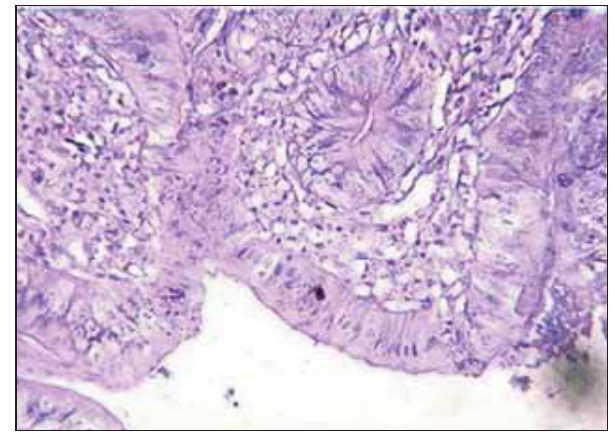
Figure-3: Group T5 showing complete destruction of intestinal villi with large number of megaschizonts (arrow) (H & E